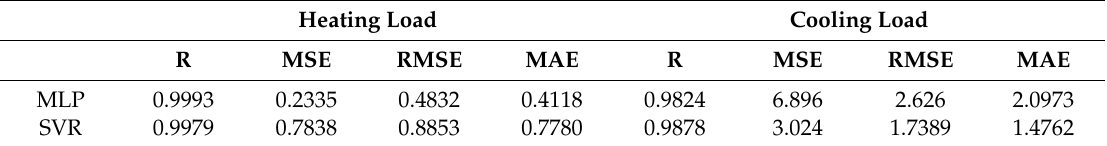
Table 2. Results of accuracy and error for proposed methods in heating and cooling load prediction.